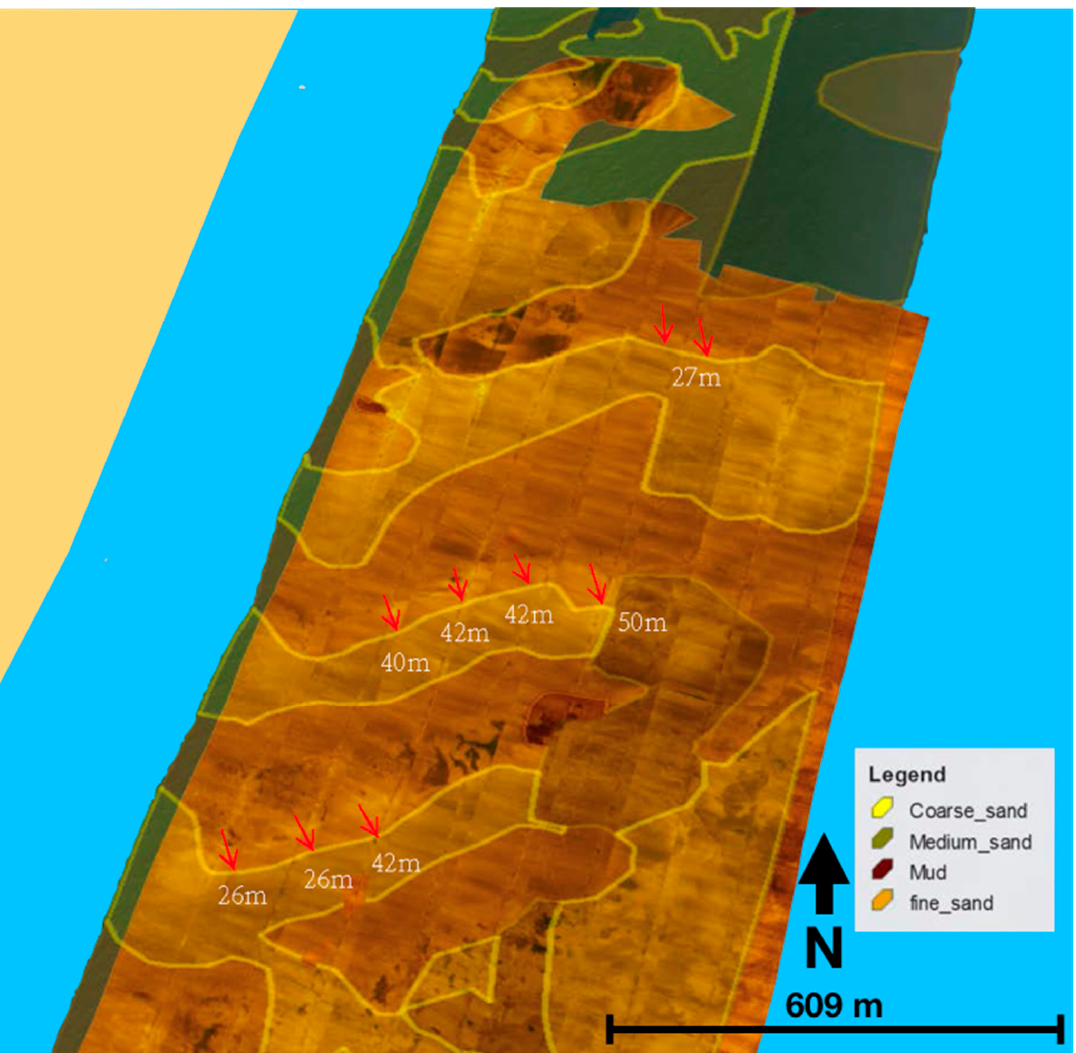
Figure 15. Temporal changes in sediment class boundaries, Assateague Island National Seashore, Maryland. The underlying image on the bottom is the side-scan sonar mosaic collected during May 2015. Shaded polygons on the top represent sediment classes inferred from the side-scan sonar mosaics collected during October 2015. Note the southeastward shift (18–50 m) in the boundary of fine-coarse sand sediment classes.